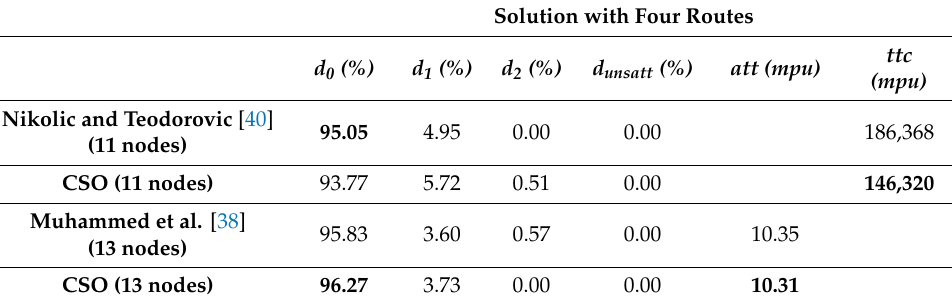
Table 9. Comparative results for the best four-route solutions for Mandl’s